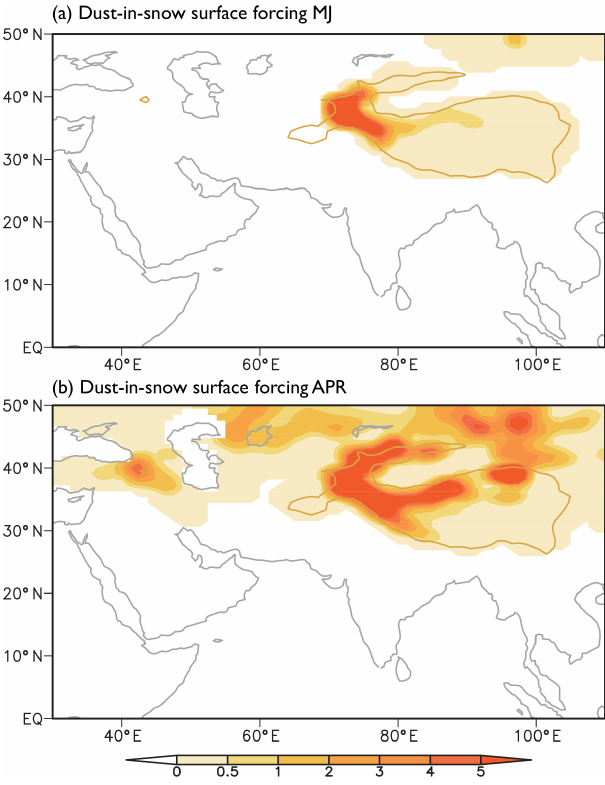
Figure 13. Surface forcing of dust-in-snow during May to June (Wm − 2 , a ) and April (Wm − 2 , b ). Yellow line shows the profile of the Tibetan Plateau above